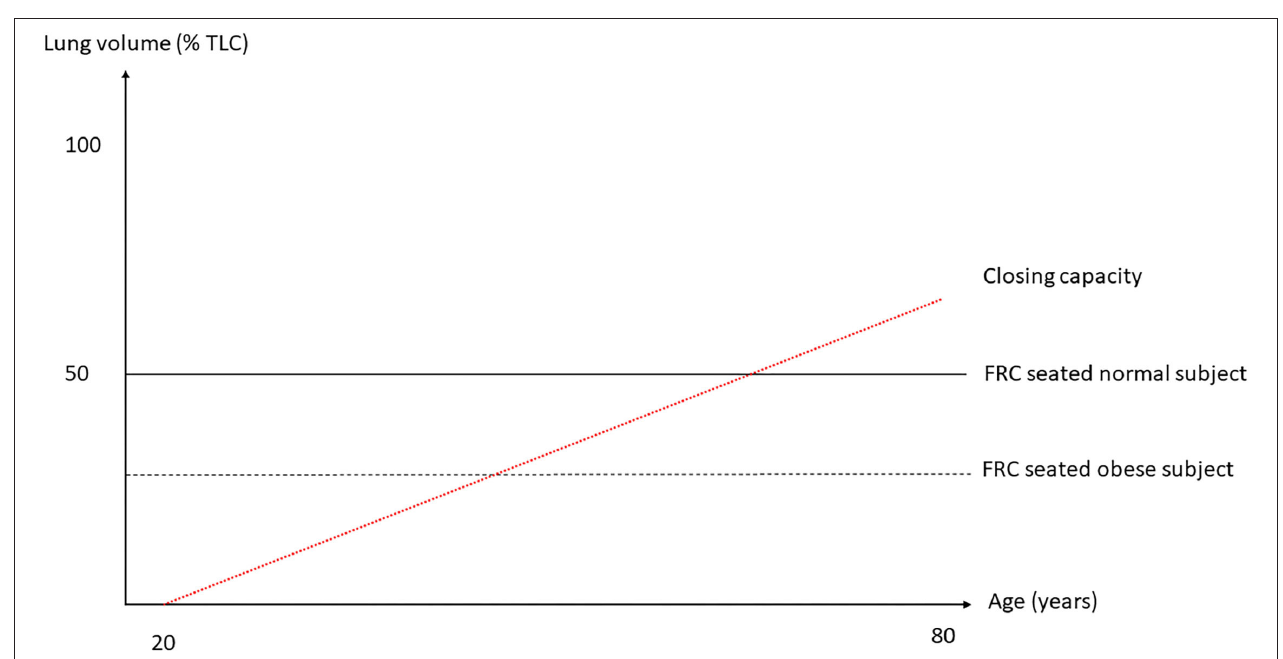
FIGURE 2 | Lung volumes as a function of total lung capacity (TLC) against age. The two horizontal broken lines are FRC seated in normal and obese subject and the red broken line the trend of closing capacity with age. As closing capacity increases with age, an obese subject, in whom FRC is lower, would be likely to exhibit airway closure at a younger age than a non-obese subject. Not shown here is the fact that FRC goes down with increasing body mass index.